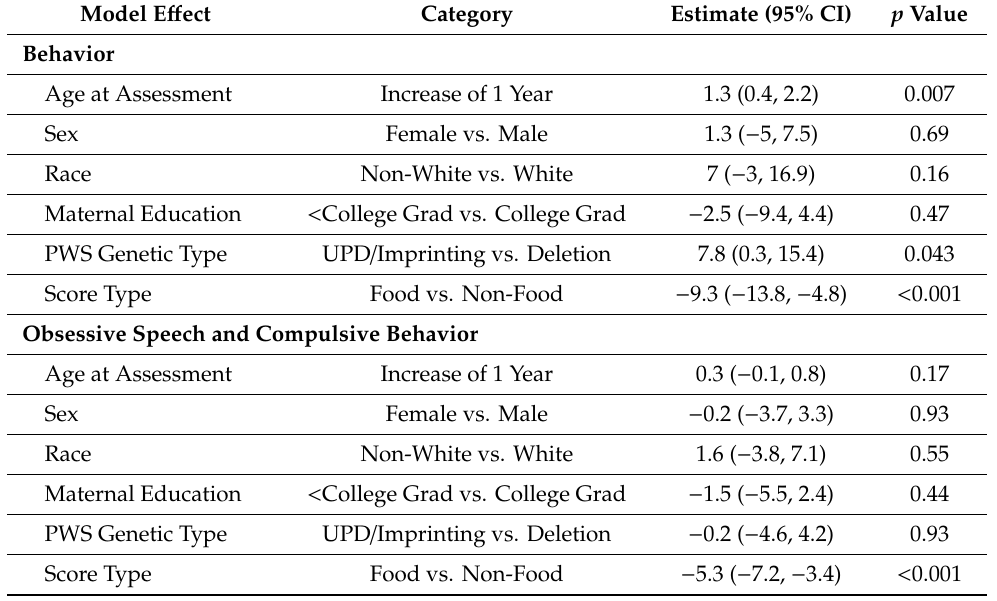
Table 5. Model Results Comparing Food- and Non-Food-Related Scores for Teacher-Reported GAIB